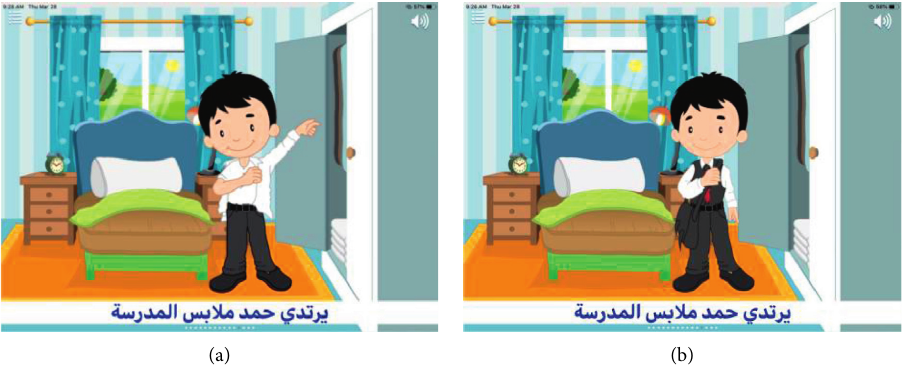
Figure 3: eStories with minor